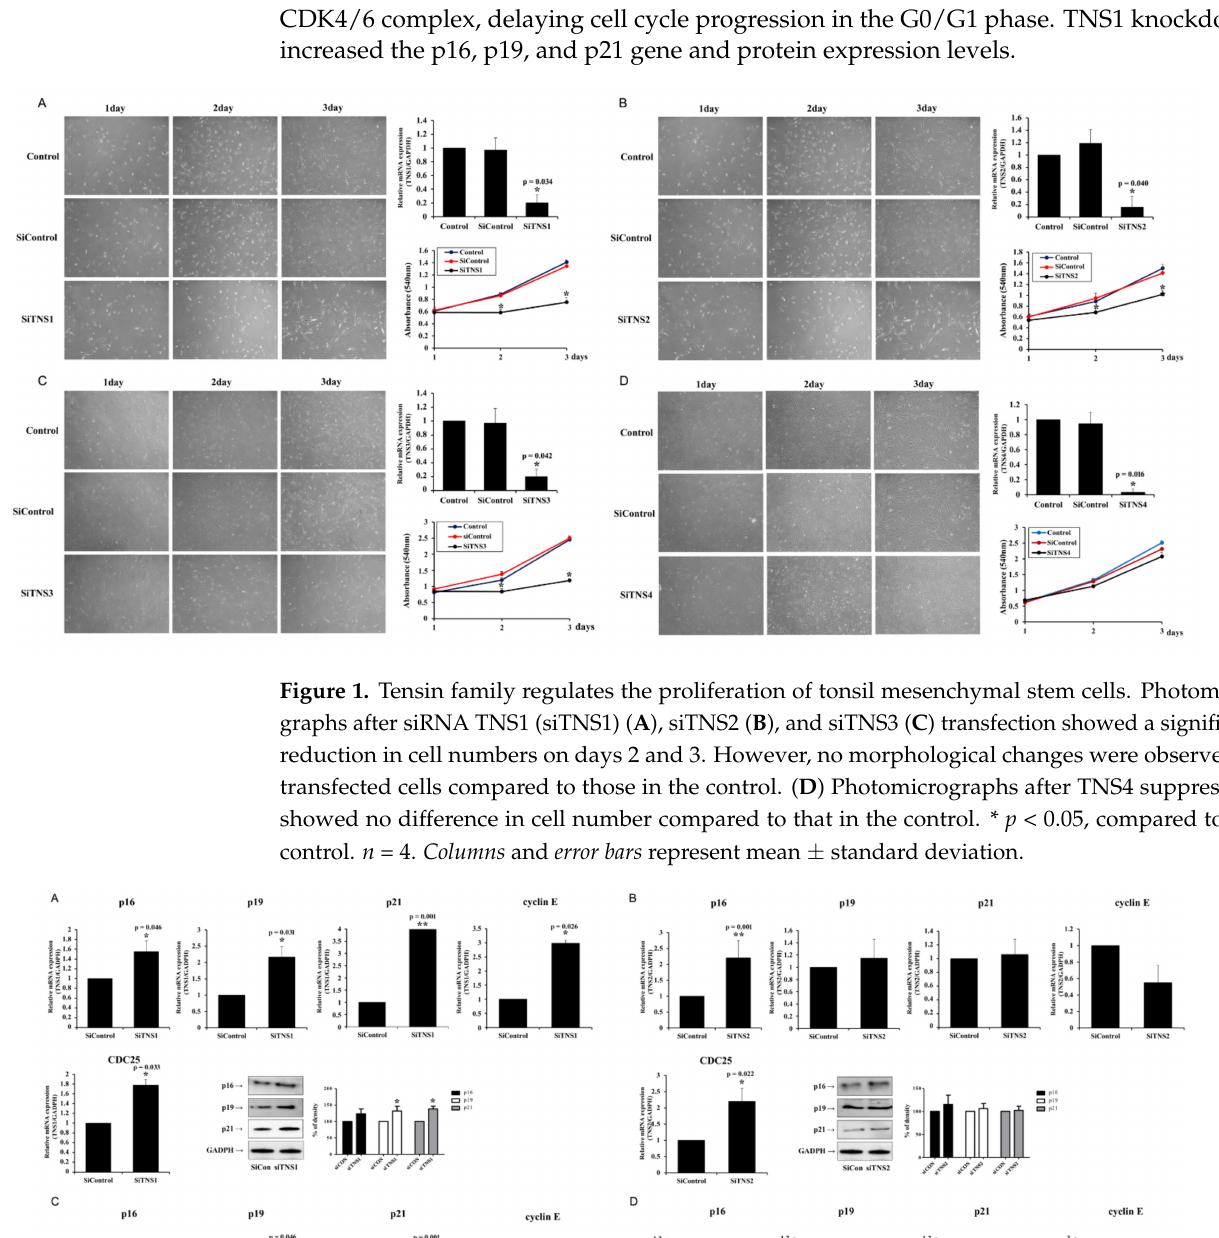
CDK4/6 complex, delaying cell cycle progression in the G0/G1 phase. TNS1 knockdown increased the p16, p19, and p21 gene and protein expression levels.